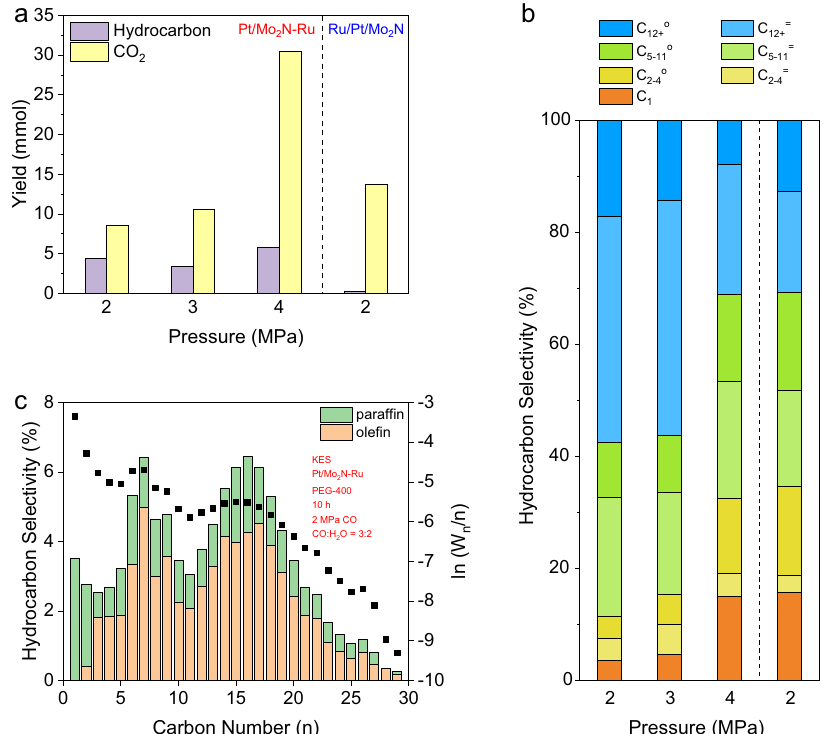
Fig. 3 | Catalytic performances of KES. a Yields of hydrocarbons and CO 2 on a carbon-atom basis. From left to right: 2, 3, and 4MPa of CO over Pt/Mo 2 N-Ru, and 2MPa of CO over Ru/Pt/Mo 2 N. b Fractional hydrocarbon selectivity. From left to right: 2, 3, and 4MPa of CO over Pt/Mo 2 N-Ru, and 2MPa of CO over Ru/Pt/Mo 2 N. = representsole fi nsandorepresentsparaf fi ns. c Detailedhydrocarbonselectivityover